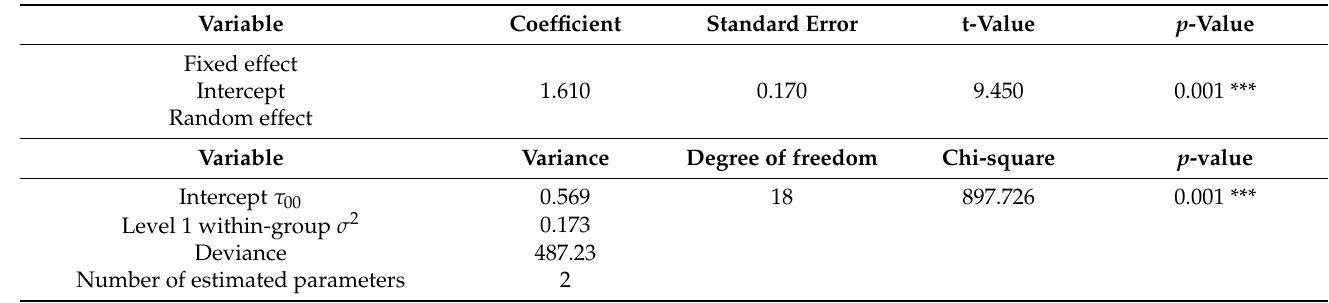
Table 4. Empirical estimation results of the null